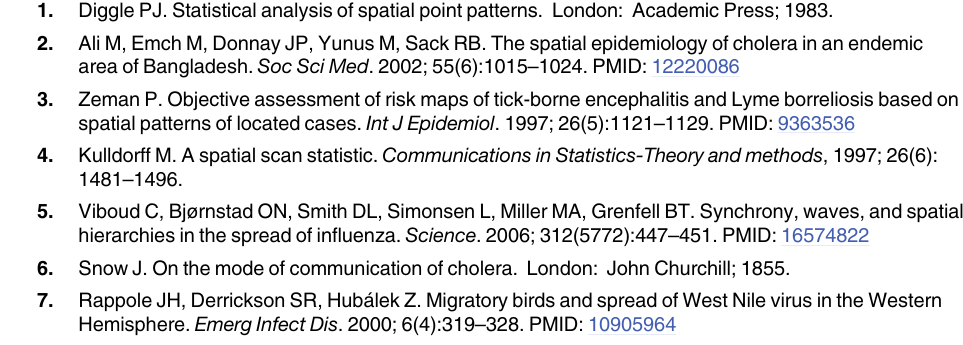
S1 Fig. Confidence intervals for Bangkok dengue example. Confidence intervals for τ ( d estimates for cases separated by (A) four months and (B) 15 months. Results from 1,912 den- gue cases that presented at a Bangkok hospital between 1995 and 1999. S2 Fig. Sensitivity analysis with different healthcare provider locations. Estimates of τ ( d ) when there is spatially biased observation dependent on the location of a pair of healthcare d 2 locations. (A) Locations of pairs of healthcare providers. (B) Estimates of τ ( d tions in (A). The color of each line is the color of the corresponding locations in (A). The solid blue line is the estimate when all cases are observed. (TIF) S1 Text. Supplementary technical